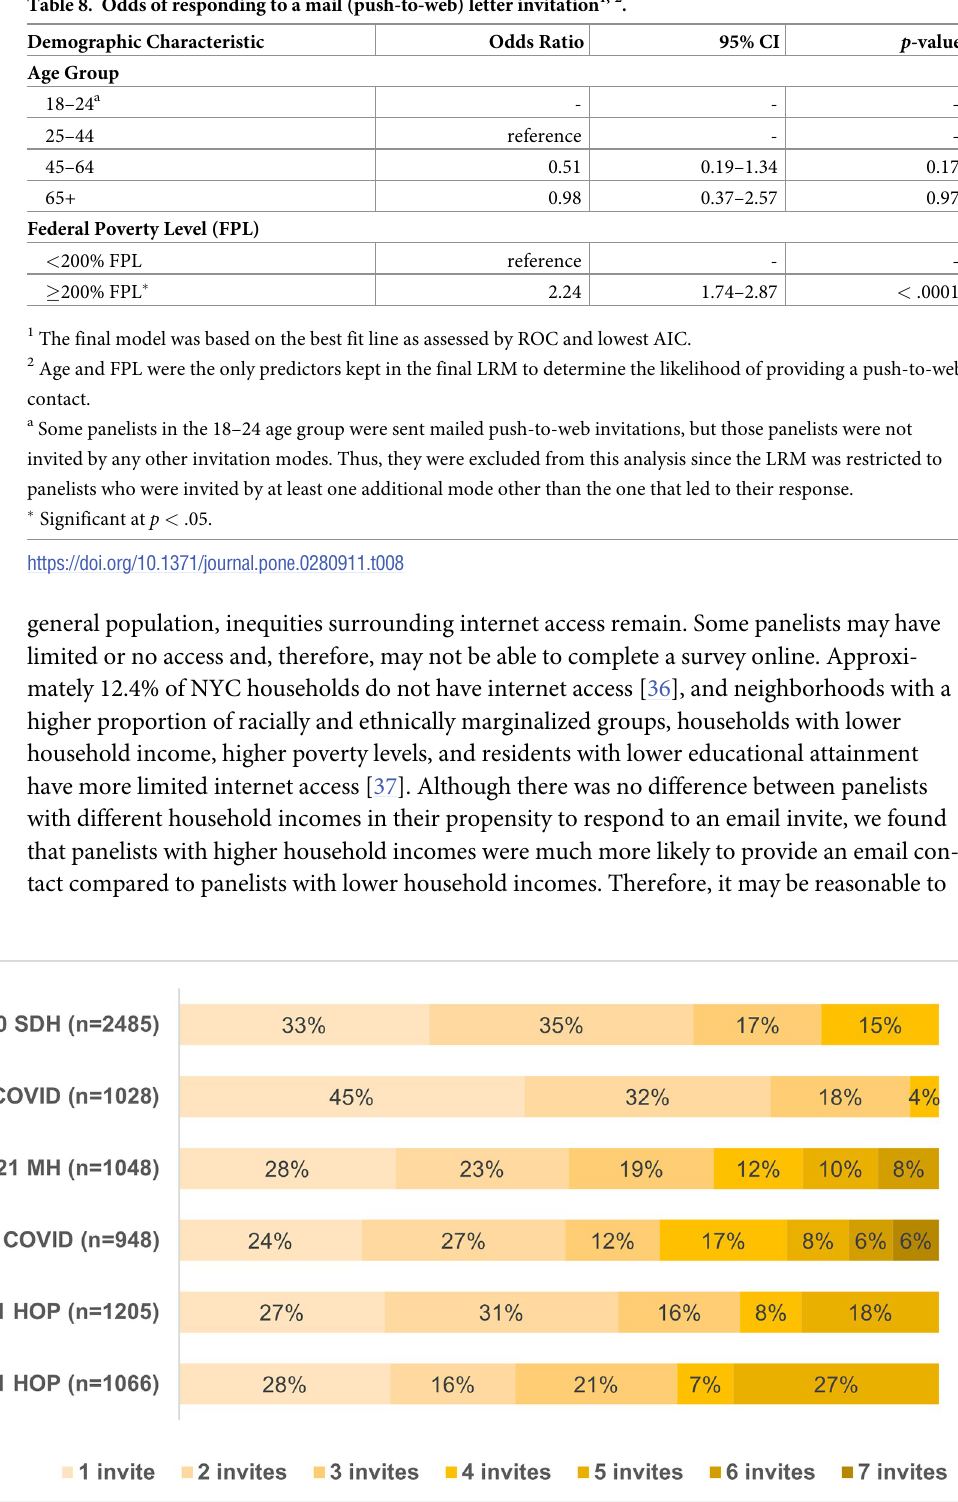
Fig 4. Number of invites participants received before response (by the total number of respondents for that